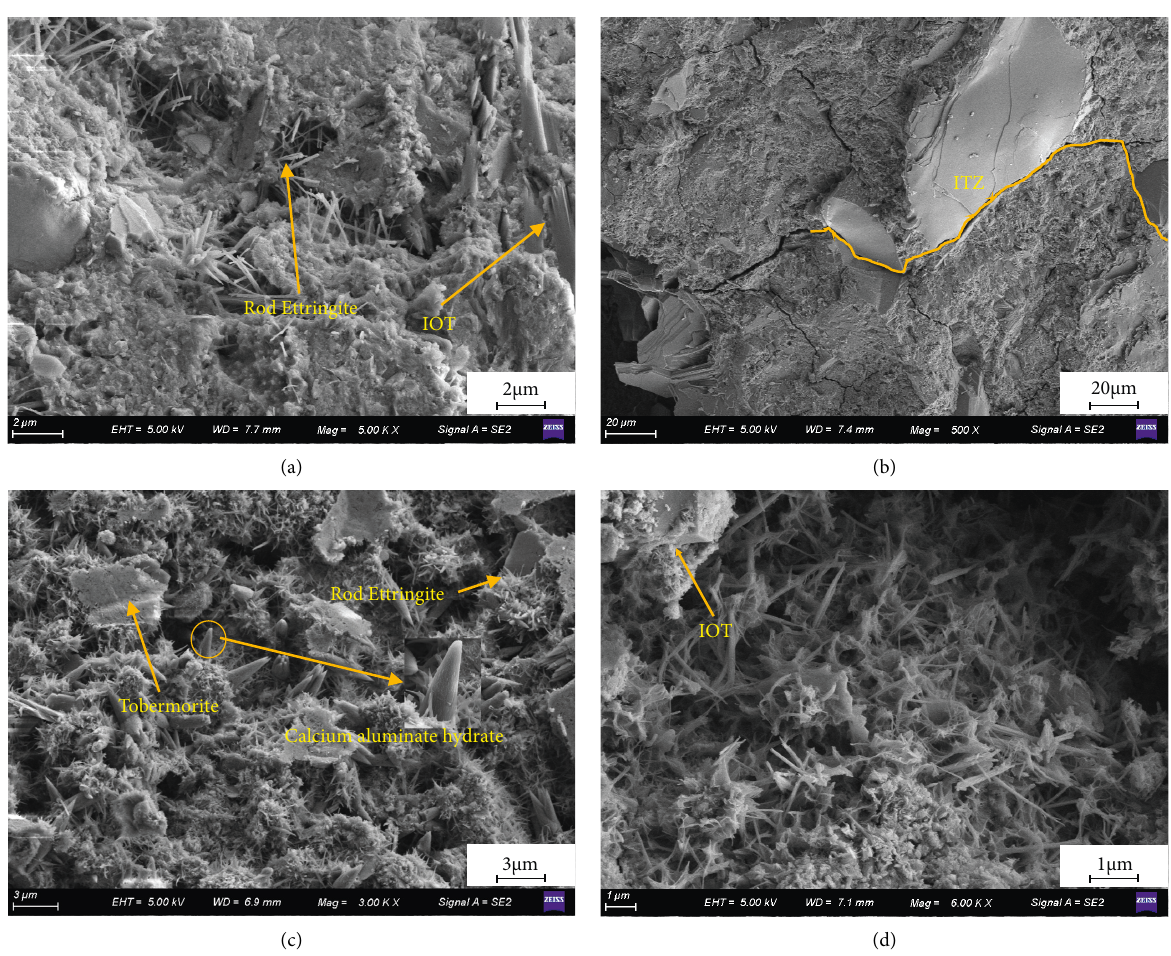
Figure 15: Microscopic damage characteristic diagram of samples (IOT replacement rate is 30%) under 200 F-T cycles: (a) RAC0-IOT3; (b) RAC3-IOT3; (c) RAC5-IOT3; (d).